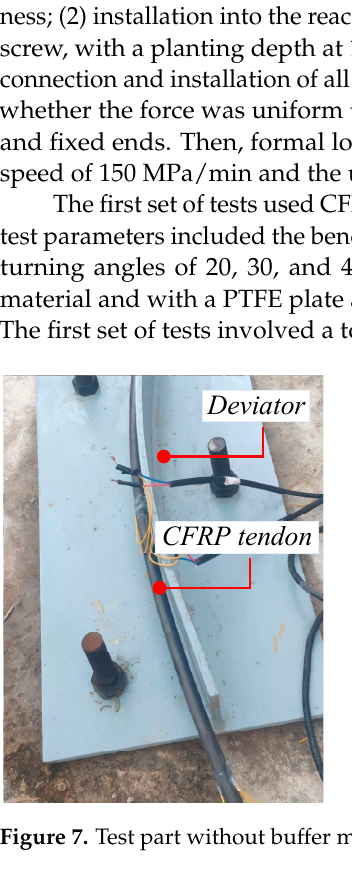
Figure 8. Test part with buffer material. Table 3. Bending test conditions of CFRP tendons. Test Conditions